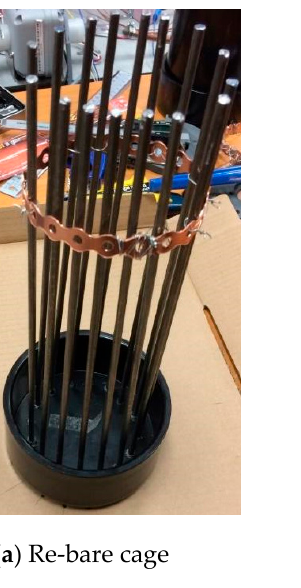
Figure 3. Experimental rebar cage.